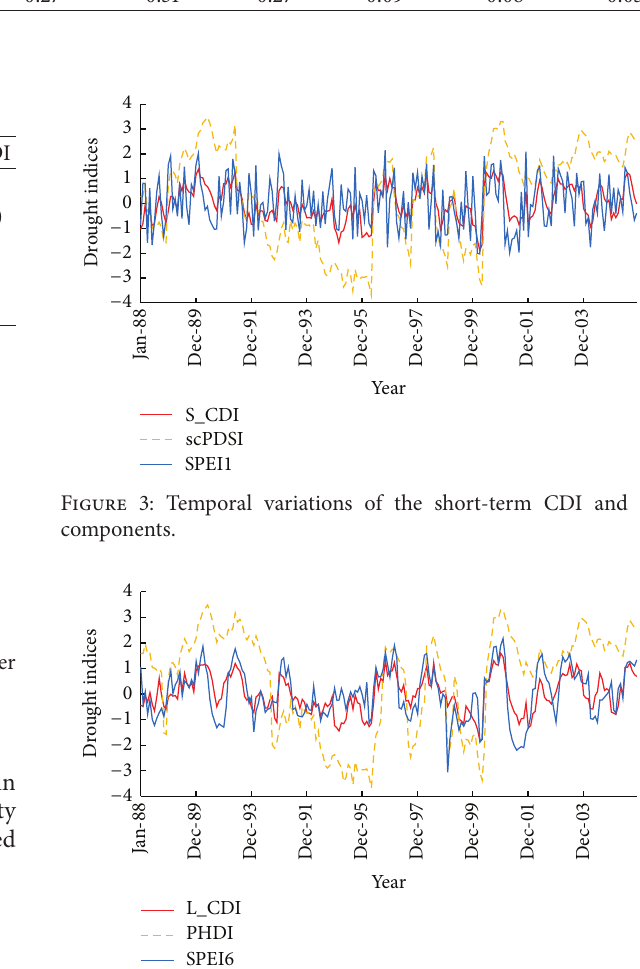
Figure 4: Temporal variations of the long-term CDI and its